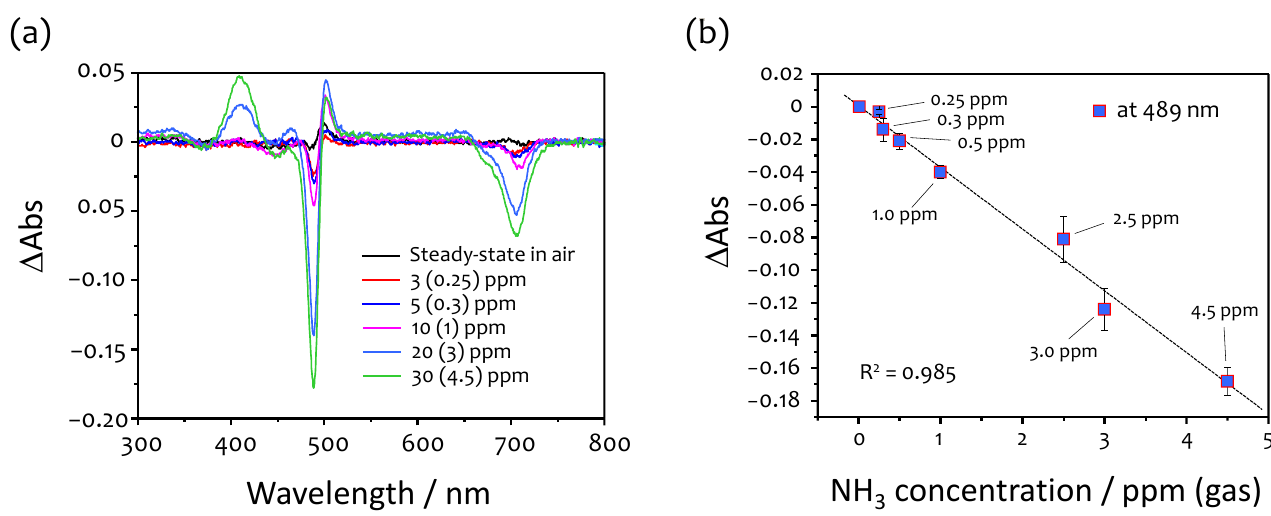
Figure 4. ( a ) Difference absorption spectra of the PDDA/TSPP film measured after exposure to ammonia gases with varying concentrations and ( b ) the dependence of the absorption value at 489 nm on the concentrations of ammonia in the gas phase. 0.038 ± 0.002 a.u./ppm (Figure 4b). Ammonia concentration measurements were repli- cated three times at each concentration, and error bars represent the standard deviation